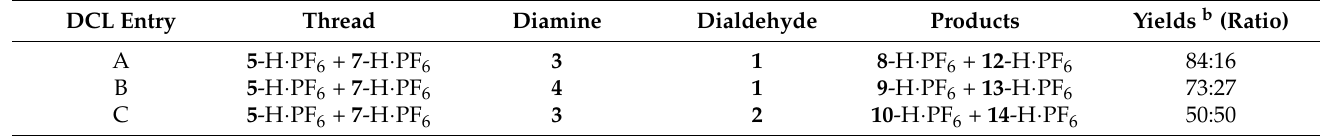
Table 1. Dynamic combinatorial libraries (DCL) of rotaxane synthesis a . DCL Entry Thread Diamine Dialdehyde